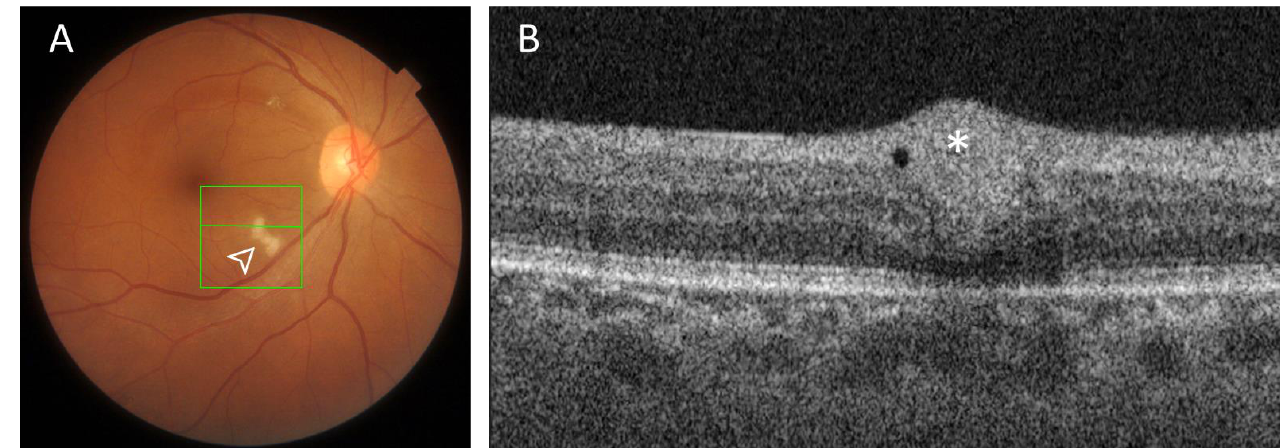
Figure 4. Right eye of a 45-year-old woman showing cotton wool spots (white arrowhead) 6 months after COVID-19 hospital discharge. ( A ). Right retinal color fundus photography of an isolated cotton wool spots (CWSs). ( B ). B-scan optical coherence tomography reveals localized swelling of the nerve fiber layer at the location of the CWSs (white asterisk).